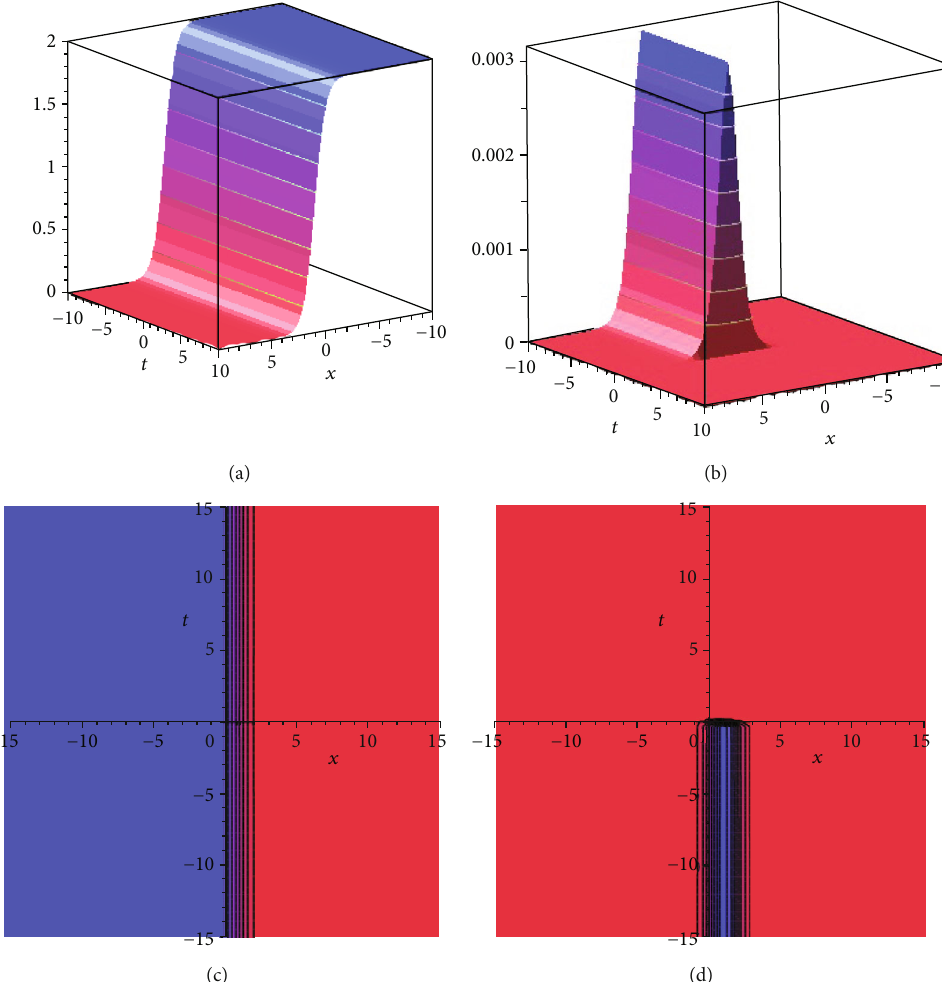
ð x , t Þ : (a) real three-dimensional shape, (b) complex three-dimensional shape, (c) 8